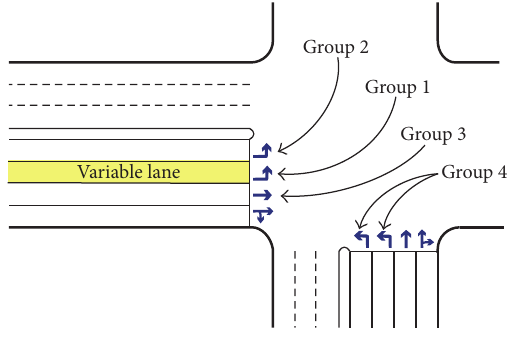
Figure 3: Data grouping